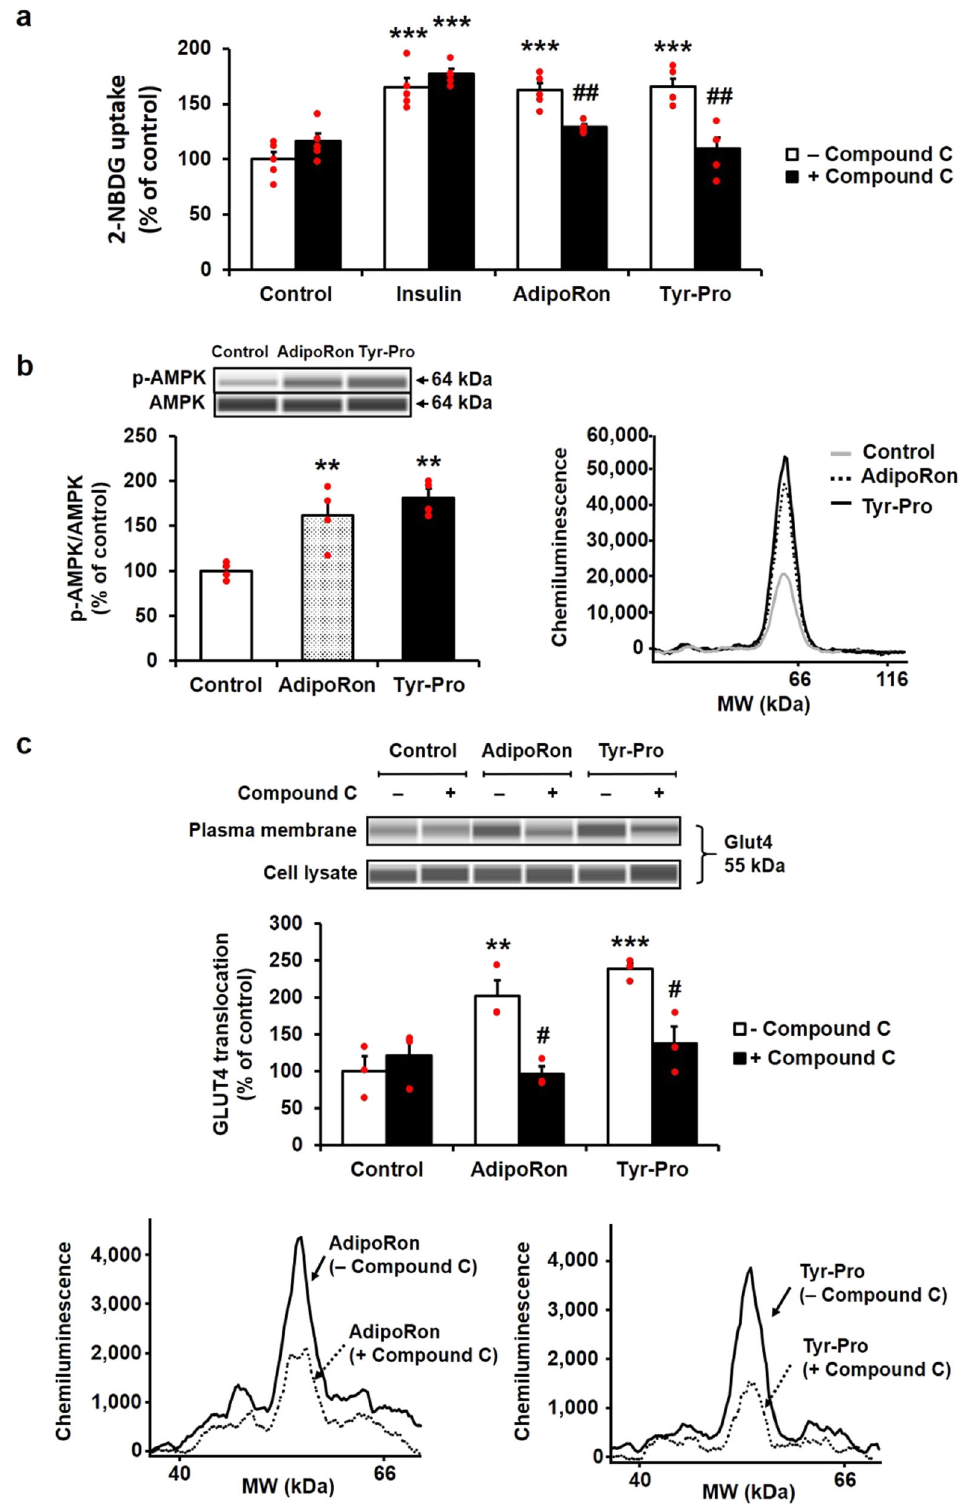
Fig. 4 The involvement of AMPK activation in Tyr-Pro-induced promotion of 2-NBDG uptake in L6 myotubes. a The effect of compound C (an AMPK inhibitor) on the promotion of 2-NBDG uptake by Tyr-Pro. L6 myotubes were incubated with 1 µM Tyr-Pro for 1 h in the presence or absence of 20 µM compound C. Insulin (0.1 µM, 0.5 h) was used as negative control (AMPK-independent uptake), while AdipoRon (0.1 µM, 0.5 h) was used as a positive control (AdipoR1-mediated AMPK-dependent uptake). The effect of Tyr-Pro on AMPK activation ( b ) and Glut4 expression ( c ) in L6 myotubes was measured using the Wes instrument. p-AMPK/AMPK in cell lysates and Glut4 protein expression in PM and cell lysates were evaluated in L6 myotubes treated with 1 µM Tyr-Pro for 1 h. Results are expressed as the mean ± SEM ( n = 3 – 5). Statistical differences were evaluated using Dunnett ’ s t -test. ** p < 0.01 vs. control, *** p < 0.001 vs. control. Statistical differences between two groups in the presence and absence of compound C were evaluated by unpaired two-tailed Student ’ s t -test. # p < 0.05, ## p <